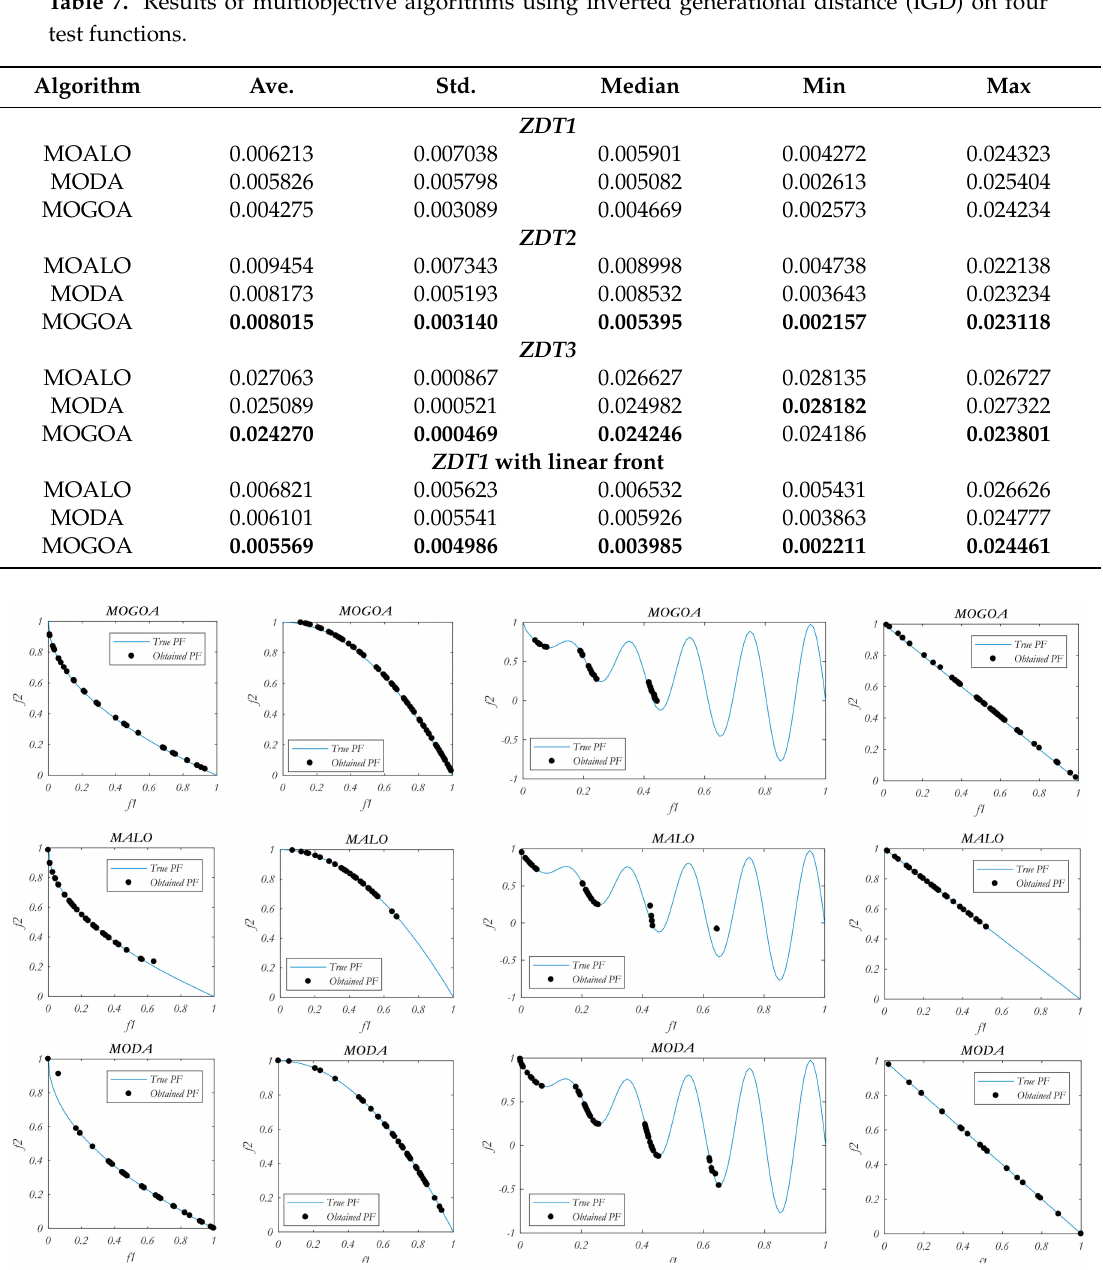
Figure 6. Pareto optimal solutions obtained by optimization algorithm for test